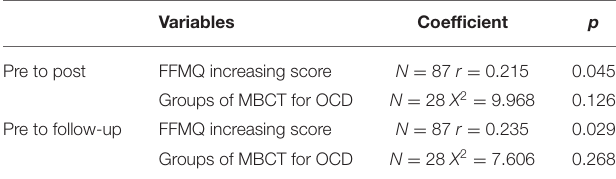
TABLE 5 | Correlations between response results and other variables.